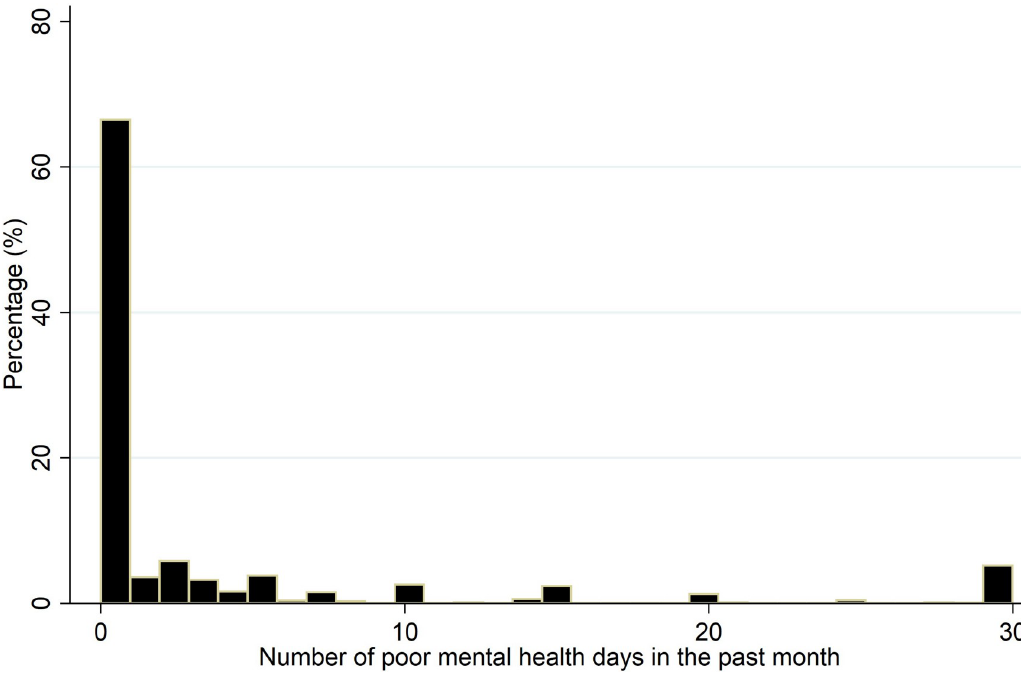
Fig 1. Distribution of bad mental health days. Data source for mental health: Behavioral Risk Factor Surveillance System (BRFSS) of the Centers for Disease Control and Prevention (CDC), 1993–2010 pooled cross-section. The distribution of bad mental health days corresponds to the question in the BRFSS survey regarding one’s mental health condition (stress, depression, and problems with emotions) for the past month.